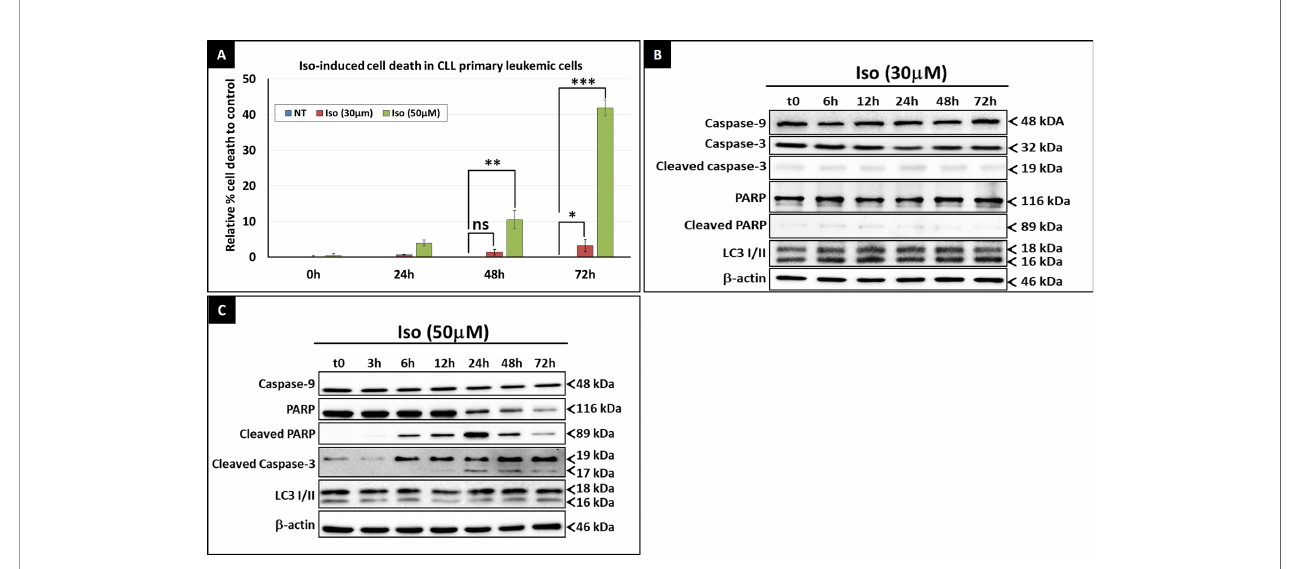
FIGURE 4 | Isoprenaline cytotoxic effect in CLL primary cells. (A) Cell viability assessment after the treatment of CPCs with either low dose of Isoprenaline (red bars) or high dose (green bars). The graph shows the relative cell-death rate to the control (basic spontaneous cell-death percentage observed in the control was subtracted from the rate observed in treated cells). Time course assessment of the cytotoxic effect of, low (B) and high (C) doses of Isoprenaline, through the quanti fi cation of apoptotic (PARP, caspase-9 and -3) and autophagic (accumulation of LC3 II) markers. [ns, non-signi fi cant (P > 0.05); *P < 0.05; **P < 0.01 and ***P < 0.001)]. Full-length blots/gels used to generate panels (B) and (C) are presented in Supplementary Figures 6 and 7